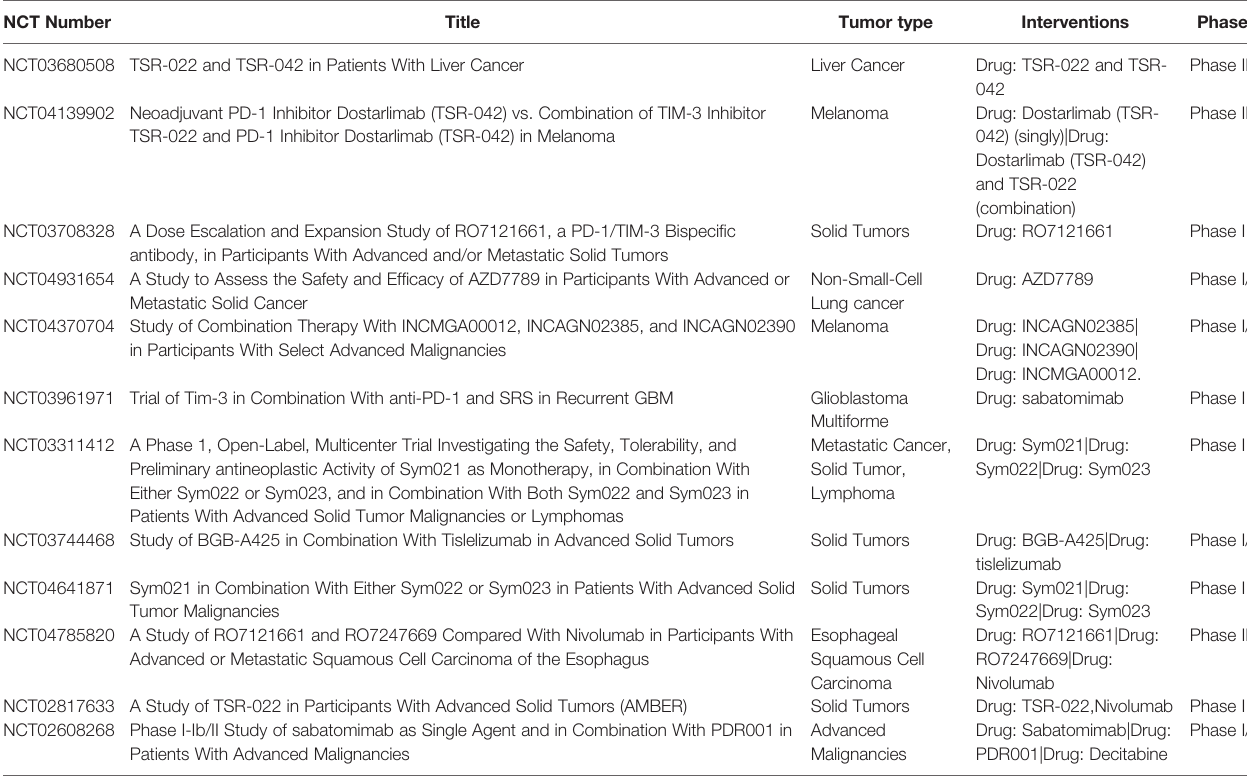
TABLE 1 | Main ongoing clinical trials of anti-Tim-3 combined with anti-PD-1